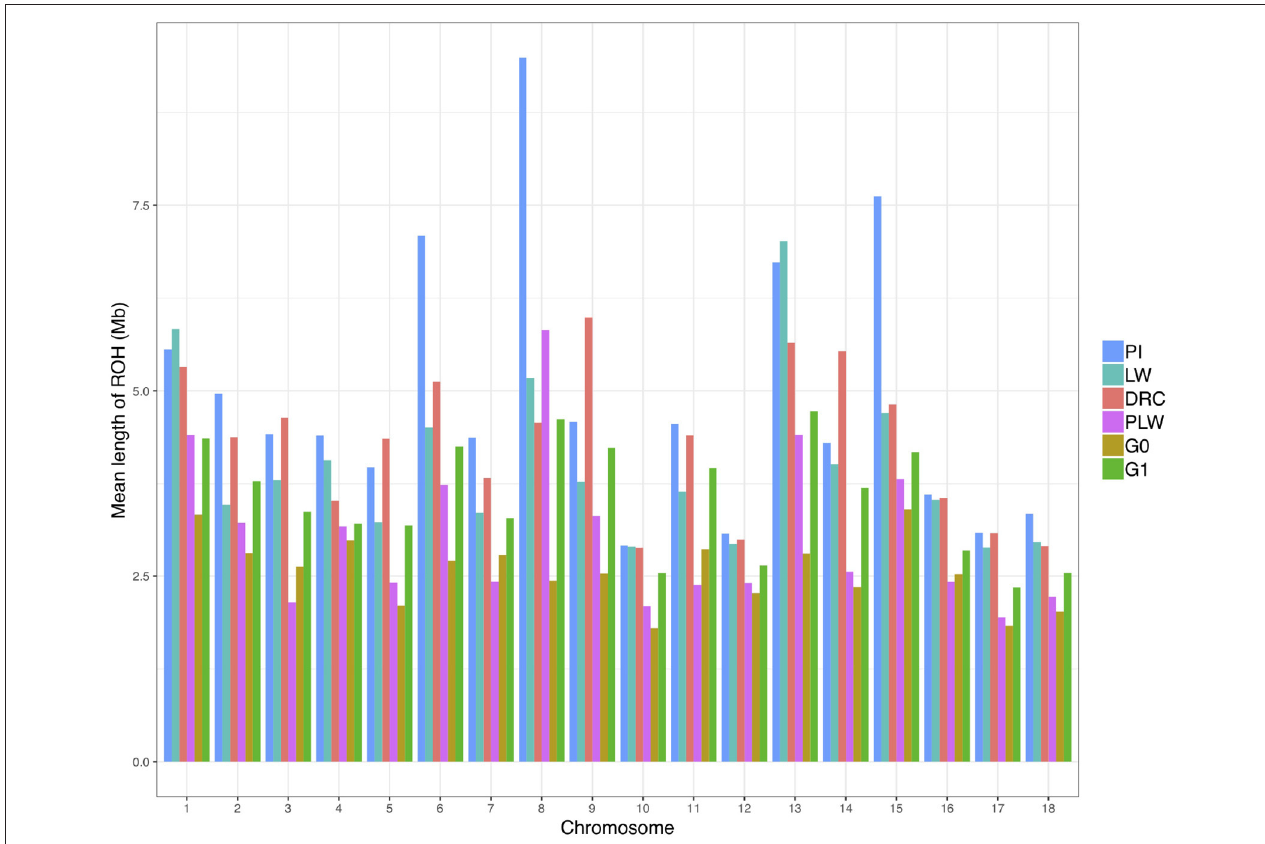
FIGURE 6 | Mean length of runs of homozygosity (ROH) detected per chromosome and group. DRC, Duroc; G0, (Pietrain × Large White) × Duroc offspring; G1, G0 × G0 offspring; LW, Large White; PI, Pietrain; PLW, Pietrain × Large